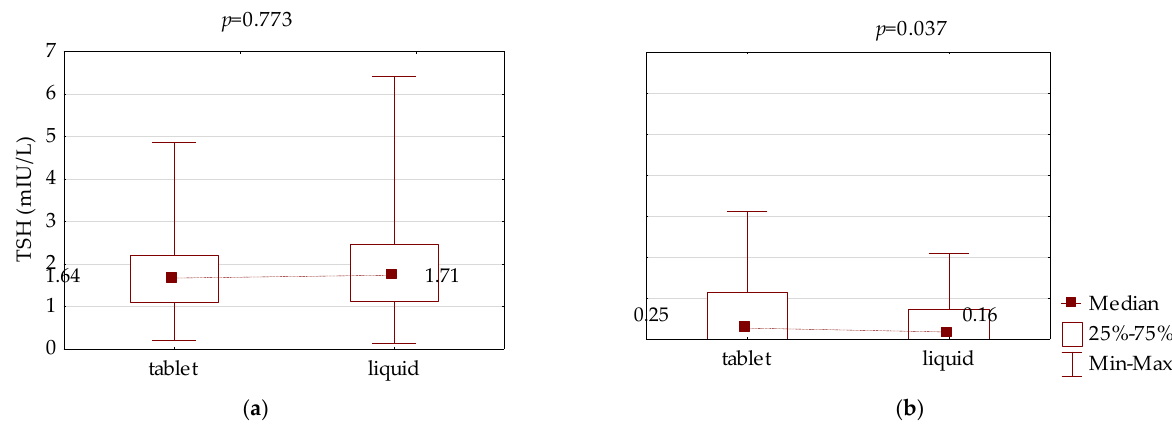
Figure 1. Comparison of TSH serum concentration between LT4 therapy in tablet and liquid form in an equivalent dose in: ( a ) primary hypothyroidism and ( b ) central hypothyroidism.